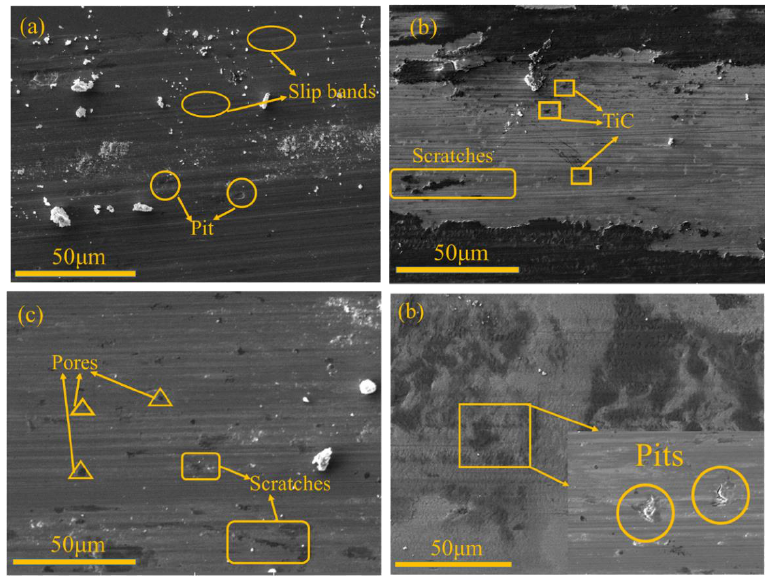
Figure 11. SEM images of the worn microstructures of the ( a ) A0, ( b ) A1, ( c ) A3, and ( d ) A5 samples.